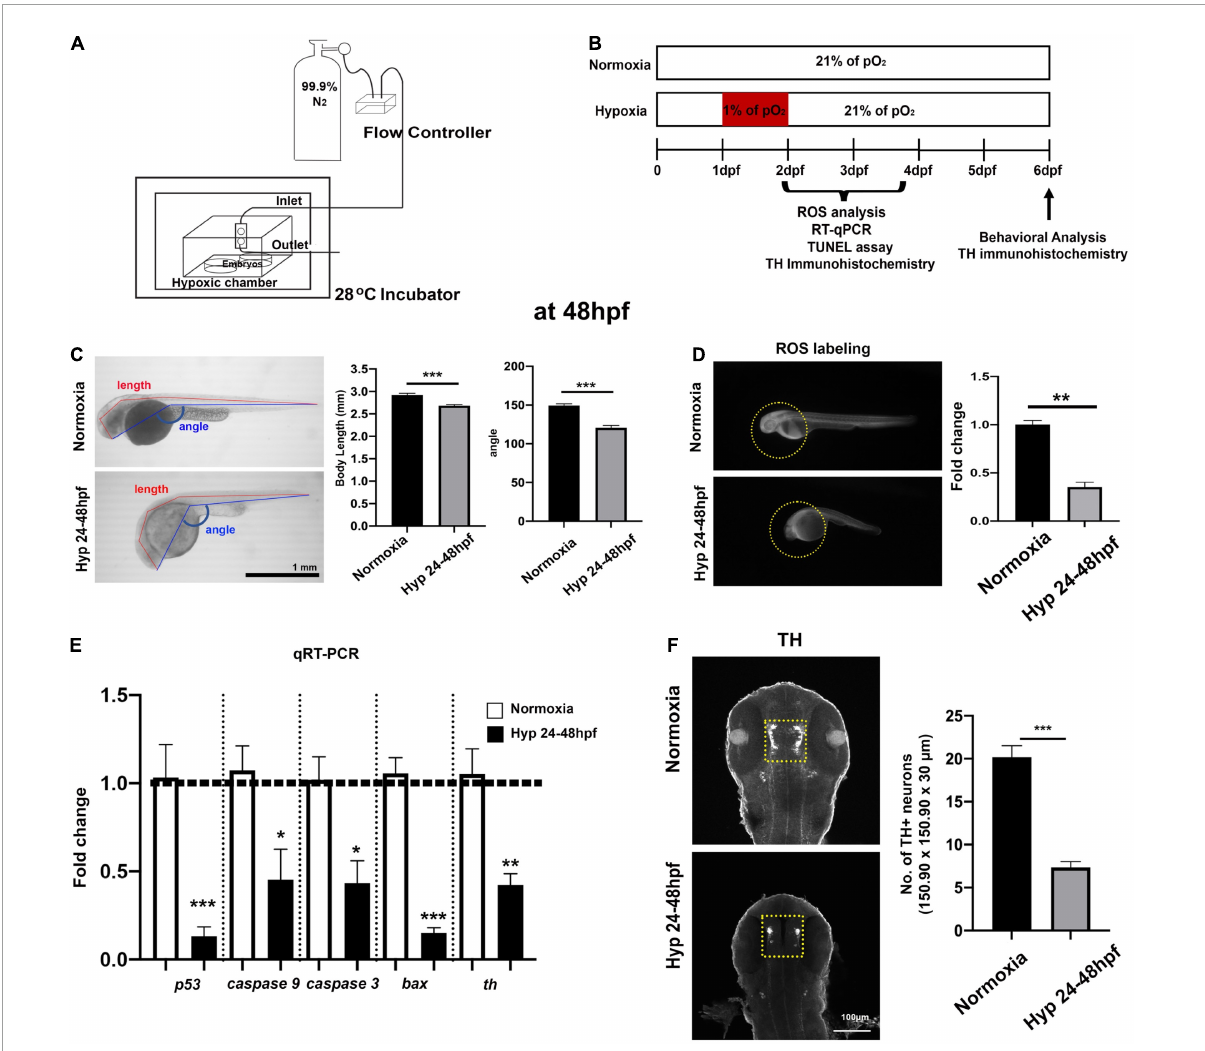
FIGURE1 Experimental setup for developmental hypoxia and procedures and the effects of direct hypoxia (Hyp)-induced toxicity at 48 hpf. (A) A schematic diagram for the hypoxia setup, (B) the timeline for the experimental procedures, (C) the whole-body images of zebrafish for the comparison of body length (mm) and head-to-tail angle (HTA) in normoxia ( n = 12) and hypoxia zebrafish ( n = 12), (D) the ROS production/accumulation in zebrafish head analyzed with Student’s t -test and presented as fold changes in hypoxic zebrafish ( n = 4) compared to controls ( n = 5), (E) the expression of proapoptotic genes ( p53, caspase9, caspase3 , and bax ) and tyrosine hydroxylase ( Th ) in hypoxic zebrafish ( n = 6/group, triplicated) corresponding to the expression of reference gene (i.e., hatn10 ) analyzed with Student’s t -test and presented by percent changes compared to normoxic controls ( n = 6/group, triplicated), and (F) Z-stack confocal images of normoxic and hypoxic zebrafish (ventral views, rostral to the top), anti-TH immunohistochemistry used to determine the number of TH + neurons in the diencephalic area (150.90 µ m × 150.90 µ m × 30 µ m) in hypoxic zebrafish ( n = 12) compared to normoxic controls ( n = 12). For this and in subsequent figures, data are shown as mean ± SEM unless otherwise noted and statistically analyzed with Student’s t -test. * p < 0.05, ** p < 0.01, and *** p <